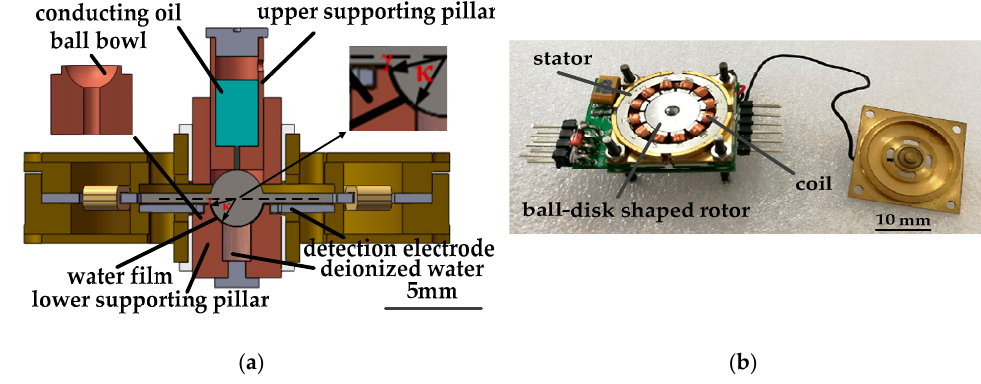
Figure 1. ( a ) engineering diagram of the gyroscope; ( b ) photograph of the gyroscope. Figure 1. ( a ) Engineering diagram of the gyroscope; ( b ) photograph of the